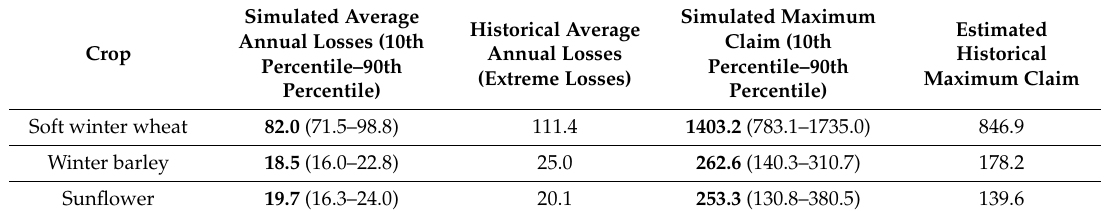
Table 1. Comparison of estimated historical and simulated damages (M € )—average and maximum—at the French farm scale for three field crops: soft winter wheat, winter barley, and